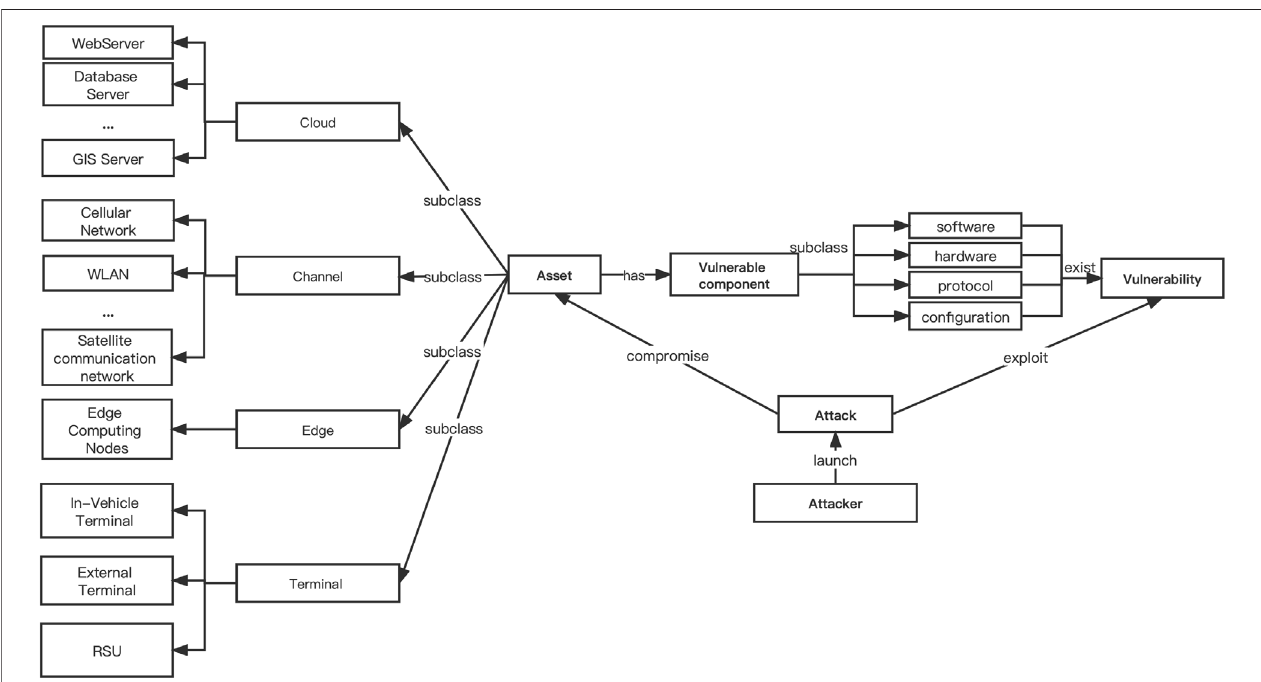
FIGURE 3 | IoV security